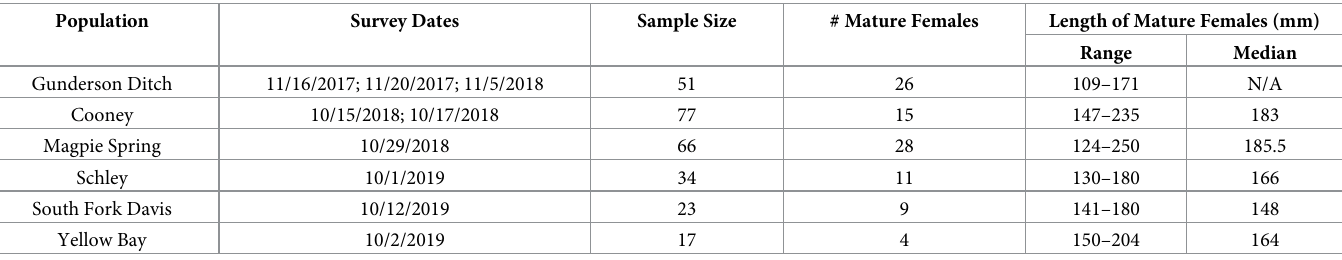
Fish collection in Gunderson Ditch generally focused on individuals under 150 mm in total length. This was not representative of the entire adult populations and therefore the median size of mature females was not calculated for this